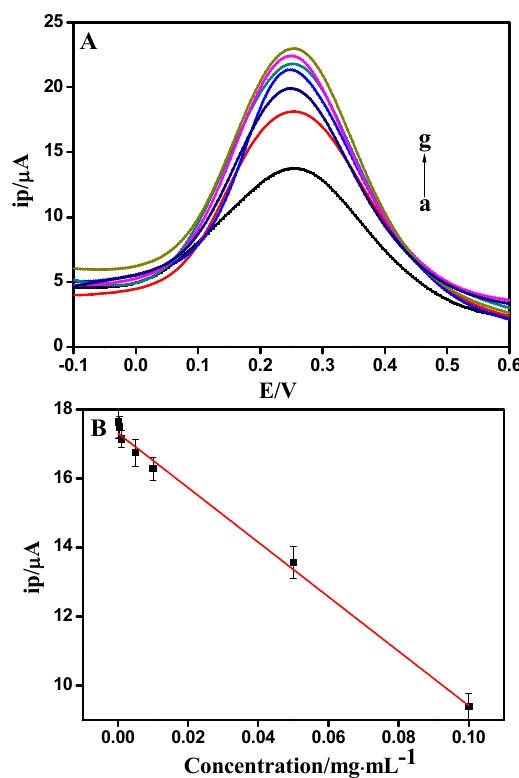
Figure 5. ( A ) Differential pulse voltammetry (DPV) obtained at anti ‐ actin/chitosan ‐ Zn/GCE in 0.1 M PBS (pH = 7.0) with the concentration of actin (from a to g) 0.1, 0.05, 0.01, 0.005, 0.001, 0.0005, 0.0001 mg/mL. ( B ) Calibration curve for anti ‐ actin/chitosan ‐ Zn/GCE.